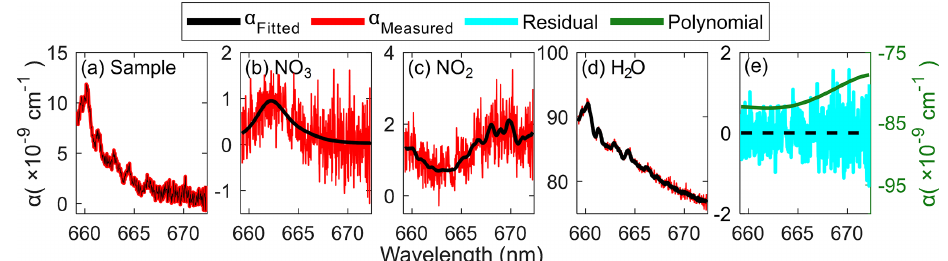
Figure 4. Spectral fitting example (2s average) of ambient data; measured (red) and fitted (black) (a) total extinction, (b) NO 3 , (c) NO 2 , (d) H 2 O, and (e) polynomial (green) with residual (cyan), respectively. Data were acquired on 26 August 2021 (UTC) from shipborne measurement on the open ocean in the Arctic region.